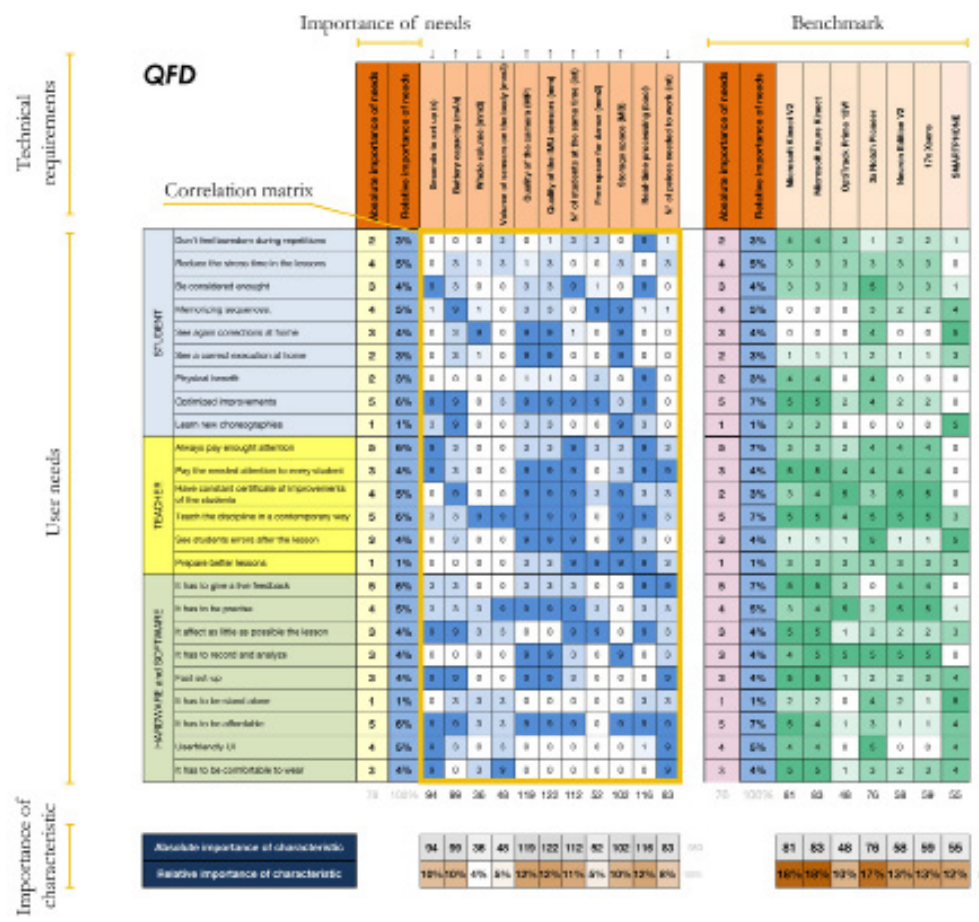
Fig. 12 Zambonini A., the Quality Function Deployment QFD matrix based on the users, stakeholders and technologies suggested the best development choices, prioritizing needs,